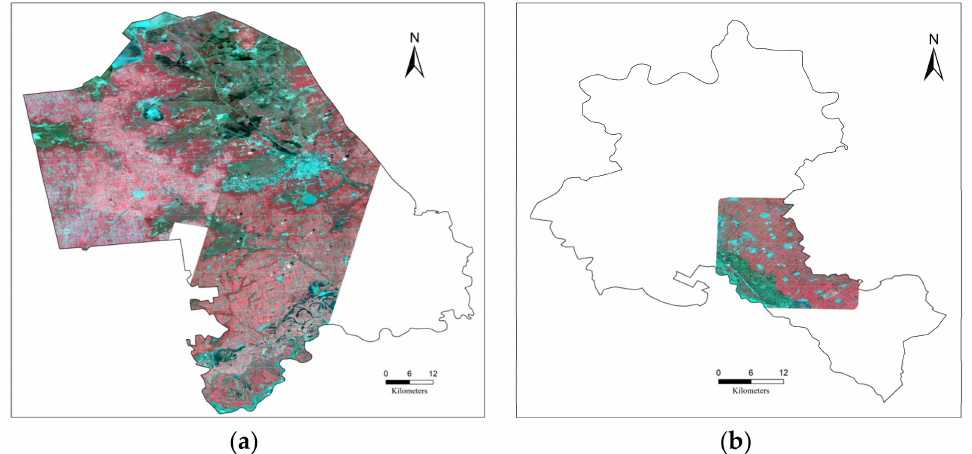
Figure 2. The scope of the Planet data coverage in a false-color image (R: band 4; G: band 3; and B: band 2) in ( a ) Zhaodong City and ( b ) Ningjiang